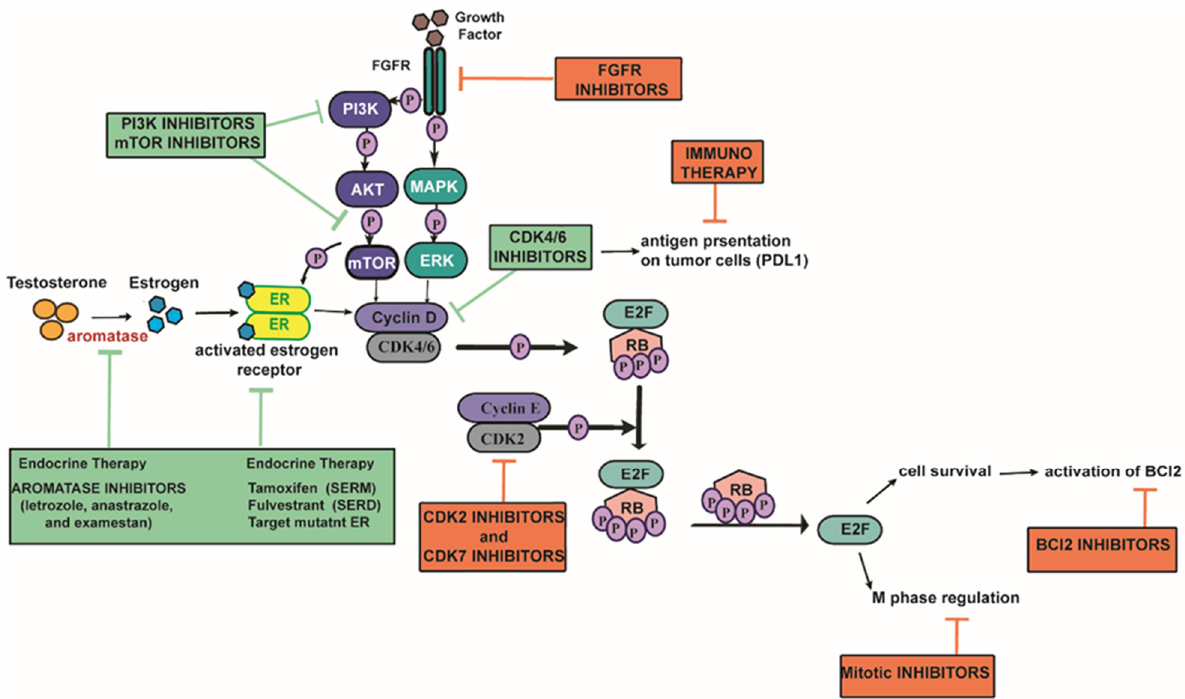
Figure 2. Signaling pathways associated with resistance to combined CDK4/6i and ET and promising combined treatments to overcome this resistance in ER+/HER2 − ABC. Treatments in green boxes are already approved by the FDA and EMA for ER+/HER2 − ABC. Pink boxes include promising treatments that are under preclinical and clinical studies.